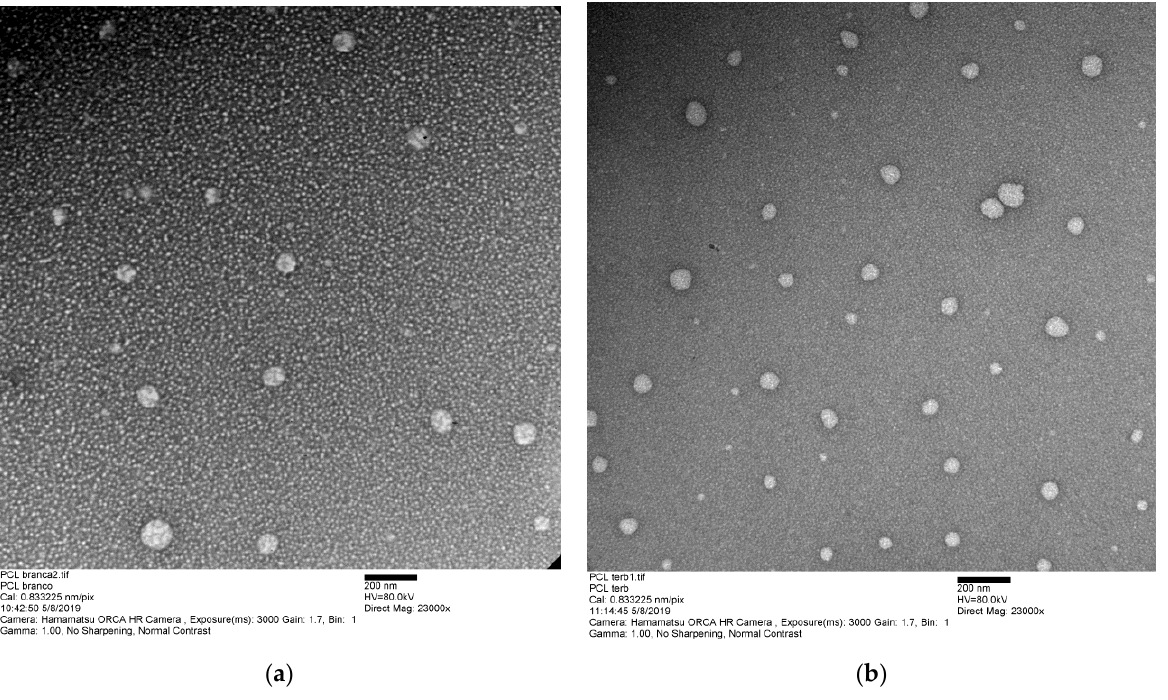
Figure 2. Transmission electron microscopy (TEM) image of PCL nanoparticles ( a ) NP-PCL and ( b ) NP-TBH-PCL in P407 2.5% solution. NP-TBH-PCL in P407 2.5%